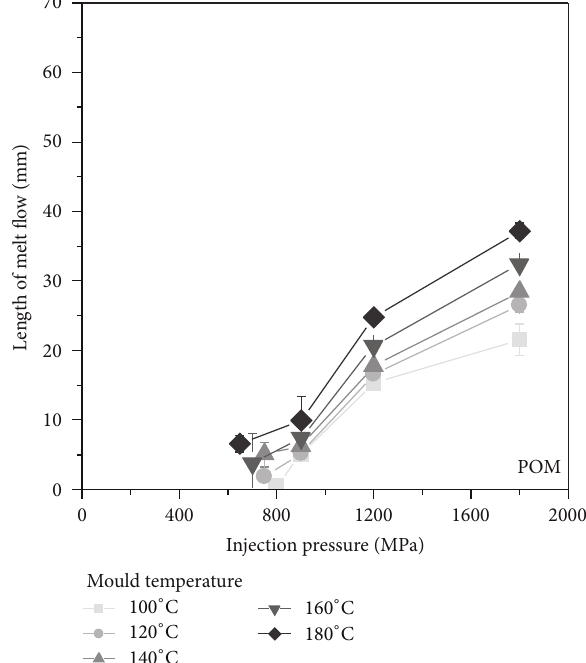
Figure 4: Flow length as function of injection pressure and mould temperature for